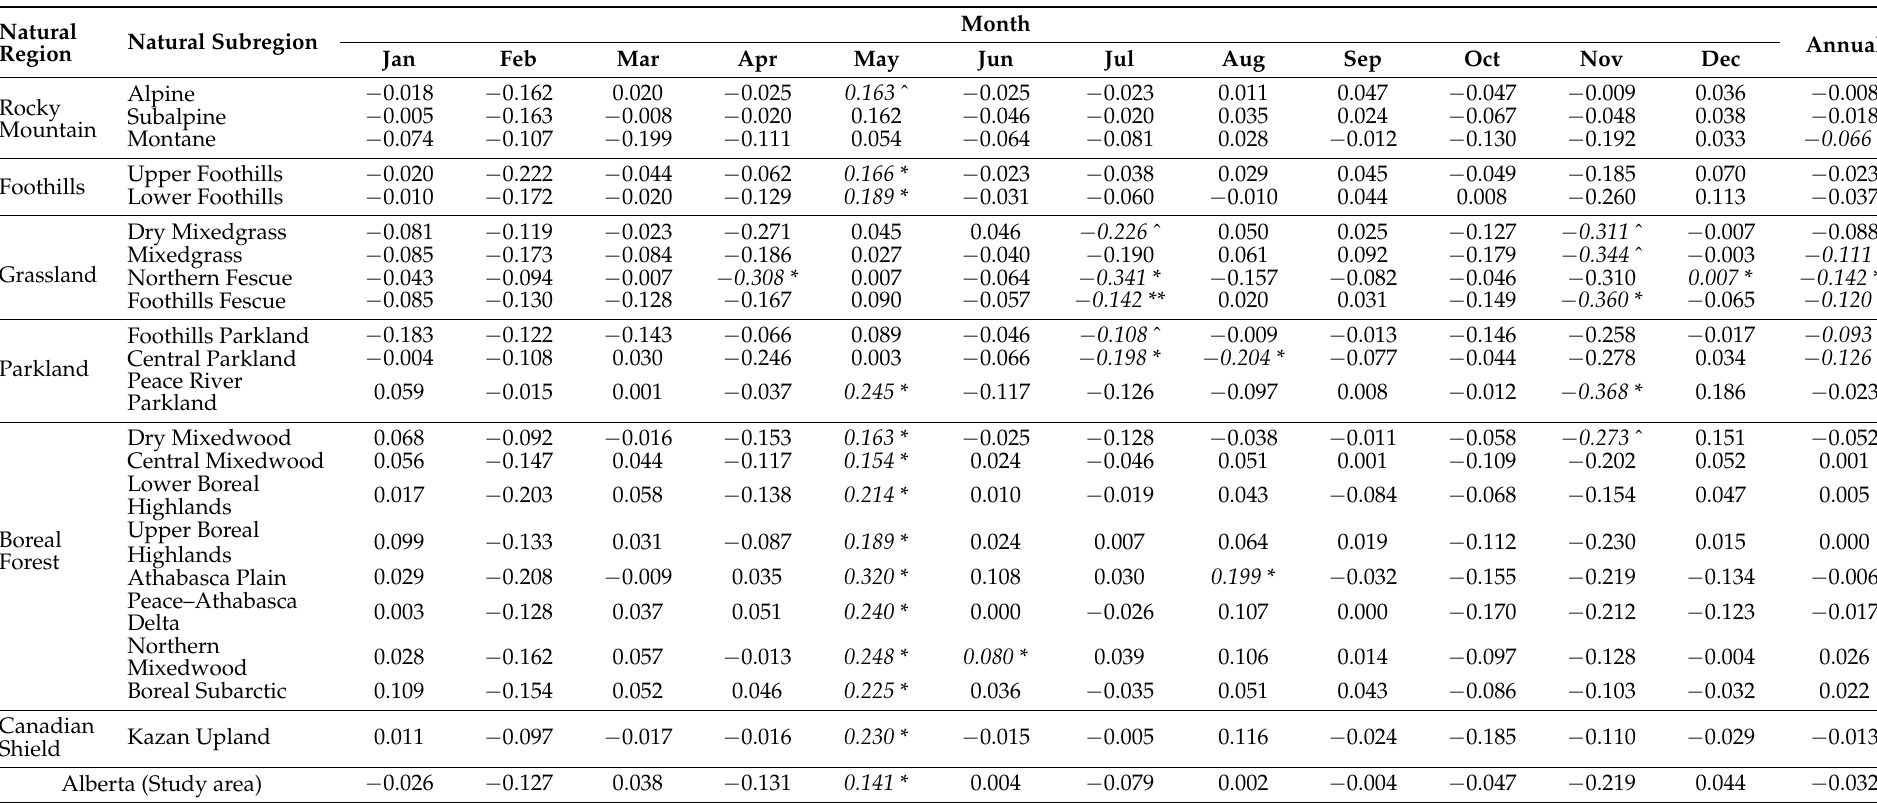
Table 1. Daytime LST trend ( ◦ C/yr) during 2001–2020 (monthly and annual) for the 21 natural subregions in Alberta using Mann–Kendall test. The significant values are highlighted italic, where ˆ, *, and ** indicate the 90, 95, and 99% confidence levels, respectively. Natural Region